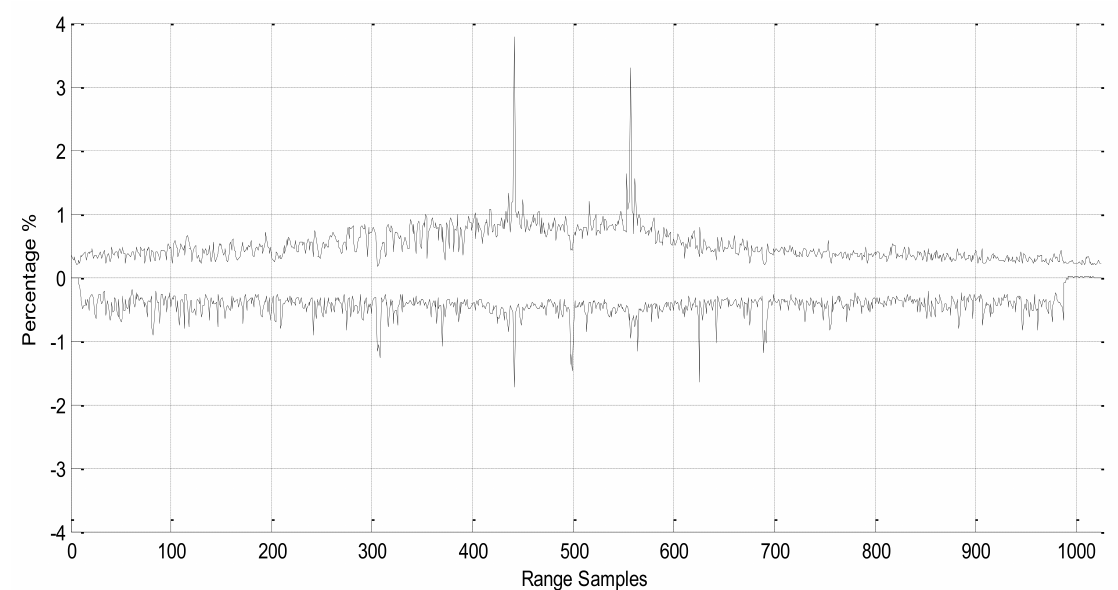
Figure 16. The difference in azimuth-compressed data, SAR image (Range Profile) by MATLAB and the proposed SAR processor.